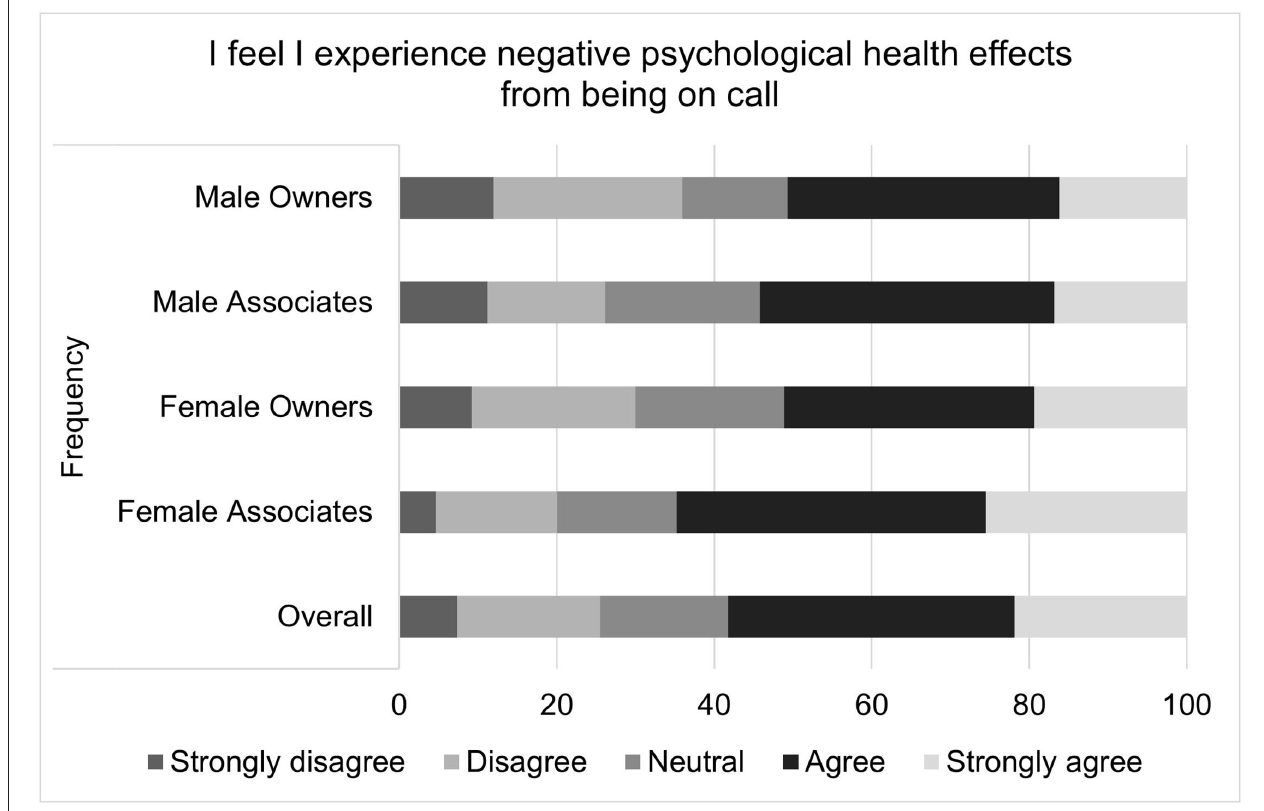
FIGURE 10 | Extent to which being on-call negatively impacts personal relationships, as reported by male and female practice owners and associate